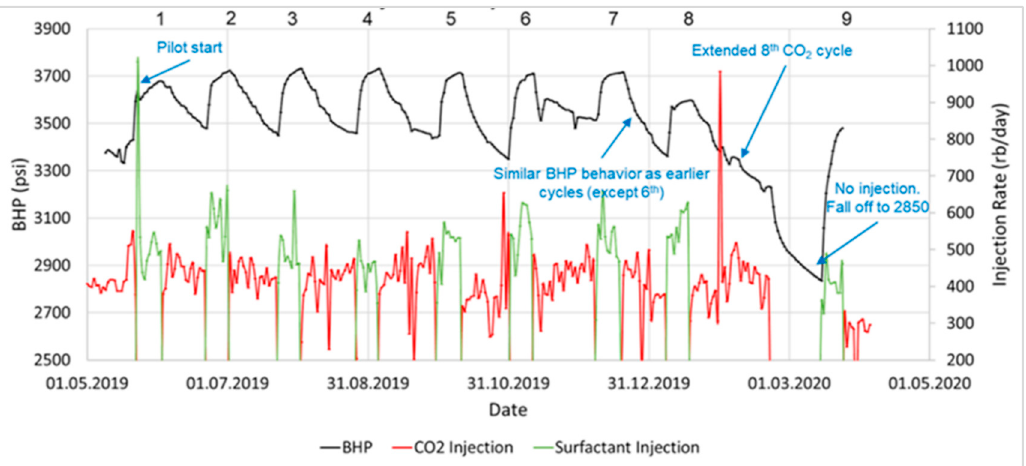
Figure 4. Plot showing the injection history along with measured bottom-hole pressures during the 9 SAG cycles.